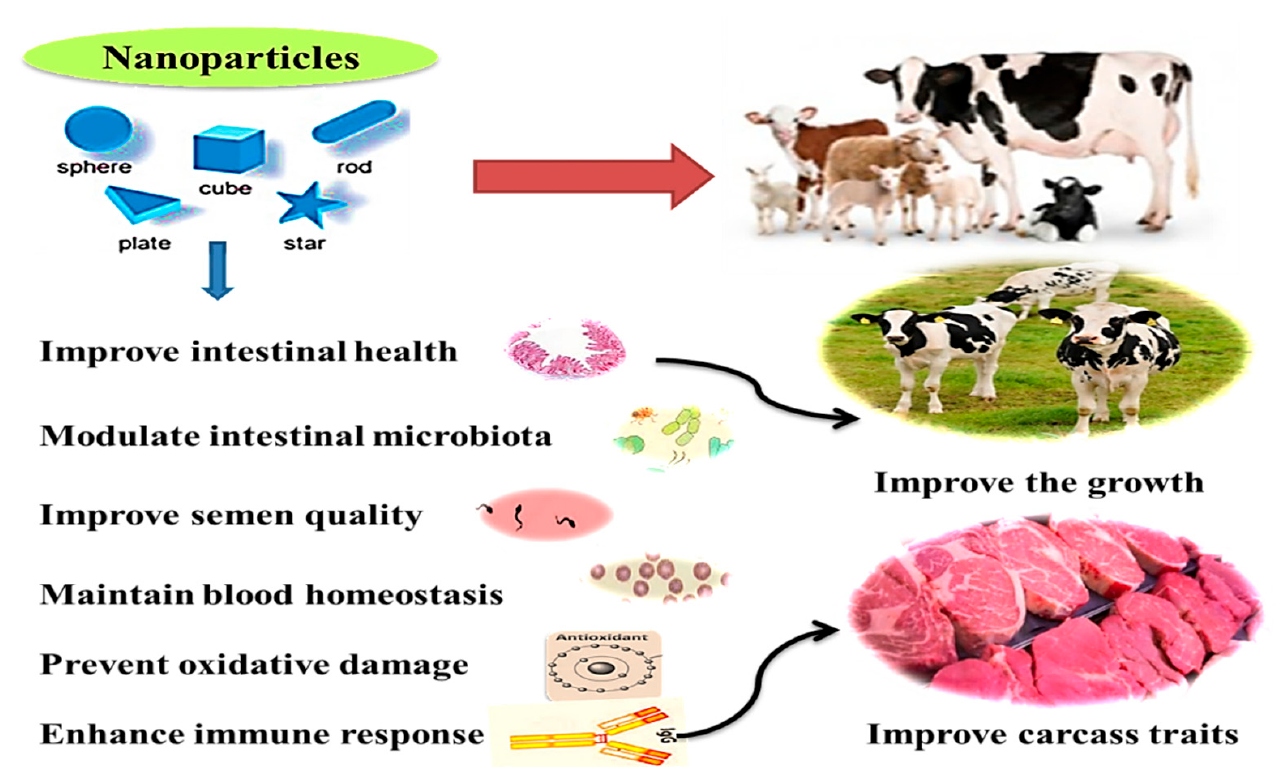
Figure 2. Health benefits and beneficial application of nano-minerals in ruminant.